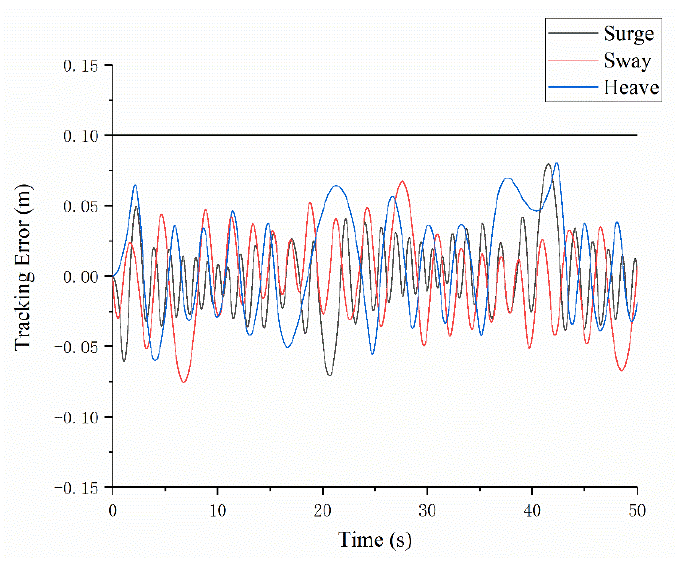
Figure 5. Tracking error of traditional scheme.